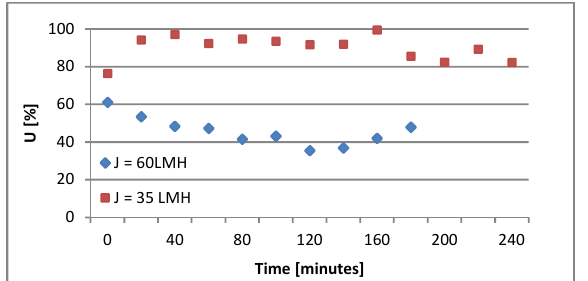
Fig. 13. Uniformity of fouling layer distribution a long hollow fiber membrane vs time at various permeate flux values (50 cm fiber length, 18 mm/s